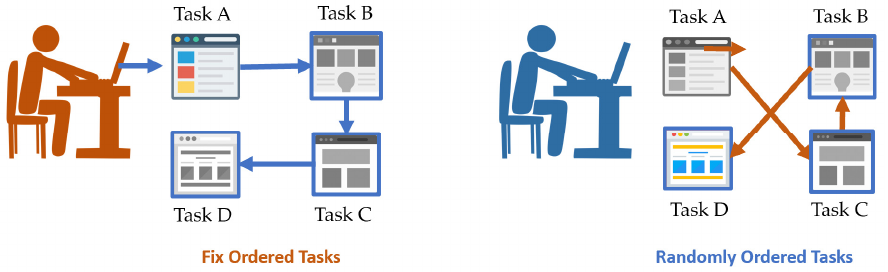
Figure 4. Comparison between fix ordered tasks and randomly ordered tasks performed when users use an online shopping website.